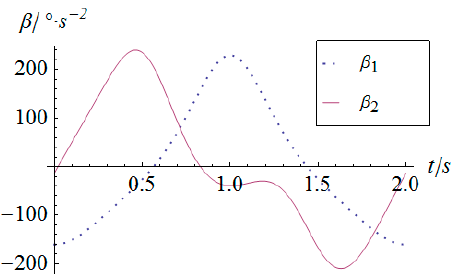
Figure 15. Angular acceleration vs. time of the actuators.